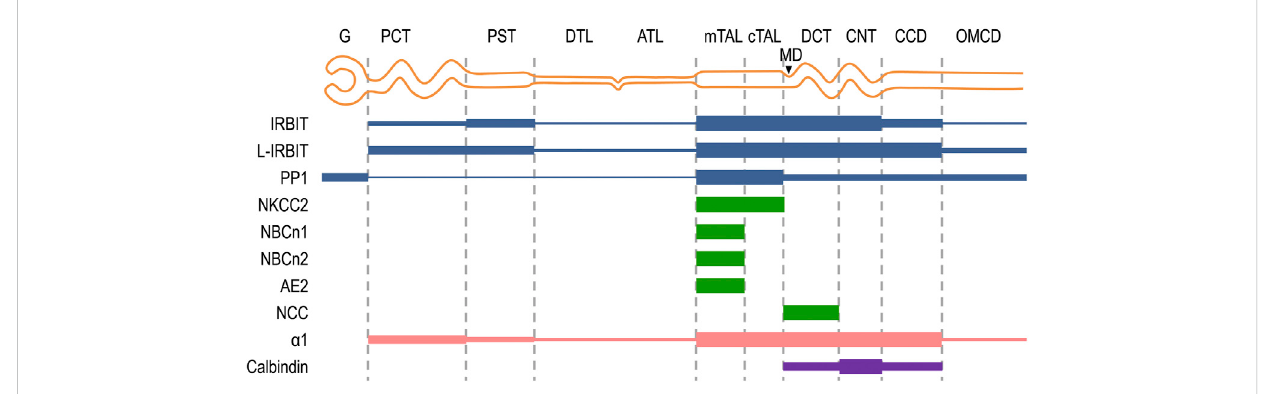
FIGURE 8 Schematic diagram summarizing the localization of NBCn1, IRBIT, L-IRBIT, PP1, NKCC2 along the nephron. The expression localizations of IRBIT, L-IRBIT, and PP1 in the kidney were systematically characterized for the fi rst time in the present study. The expression of NBCn1, NBCn2 and AE2 in the mTALwasestablishedpreviously(Alperetal.,1997;Kimetal.,2003;Praetoriusetal.,2004;Guoetal.,2017).Thepresentstudycon fi rmedthelocalization ofNBCn1inthemTAL,butnotinothersegmentsofthenephron.Thespeci fi clocalizationofNCCinDCTwasestablishedpreviously(Campeanetal., 2001). NKCC2 is a speci fi c marker for the mTAL and cTAL (Ecelbarger et al., 1996; Gimenez and Forbush, 2003). Calbindin is a speci fi c marker for DCT, CNT, and CCD (Campean et al., 2001; Wetzel and Sweadner, 2001). G, glomerulus; PCT, proximal convoluted tubule; PST, proximal straight tubule; DTL, descendingthinlimb;ATL,ascendingthinlimb;mTAL,medullarythickascendinglimb;cTAL,corticalthickascendinglimb;MD,maculadensa;DCT,distal convoluted tubule; CNT, cortical connecting tubule; CCD, cortical collecting duct; OMCD, outer medullary collecting